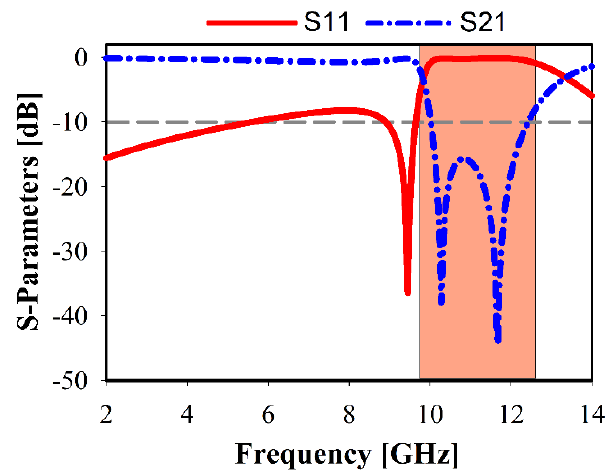
Figure 4. Simulated metamaterial reflection and transmission coefficients.